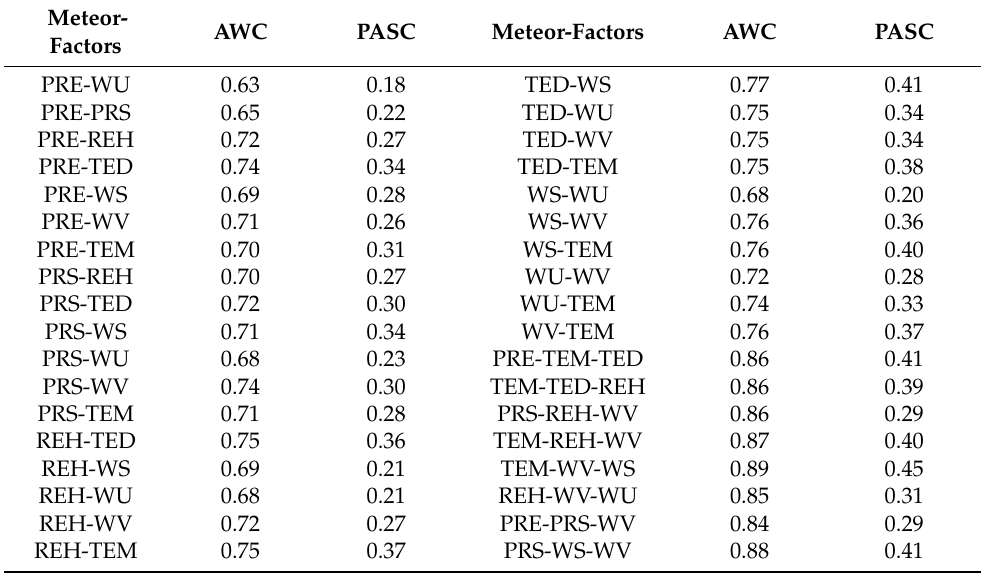
Figure 8. Multiple wavelet coherence of PM 2.5 and multiple meteorological factors. Table 2. AWC and PASC for multiple wavelet coherence.